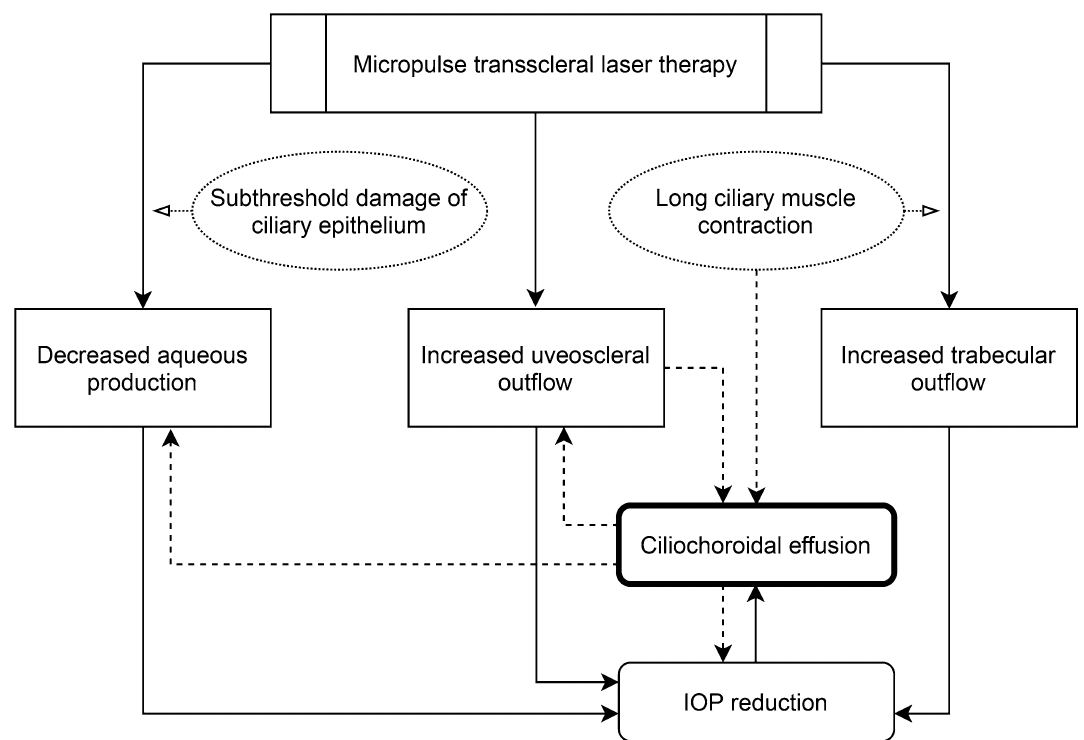
Figure 3. Possible mechanisms for intraocular pressure reduction and ciliochoroidal effusion in micropulse transscleral laser therapy. Dashed line indicates proposed mechanisms of ciliochoroidal effusion. IOP intraocular